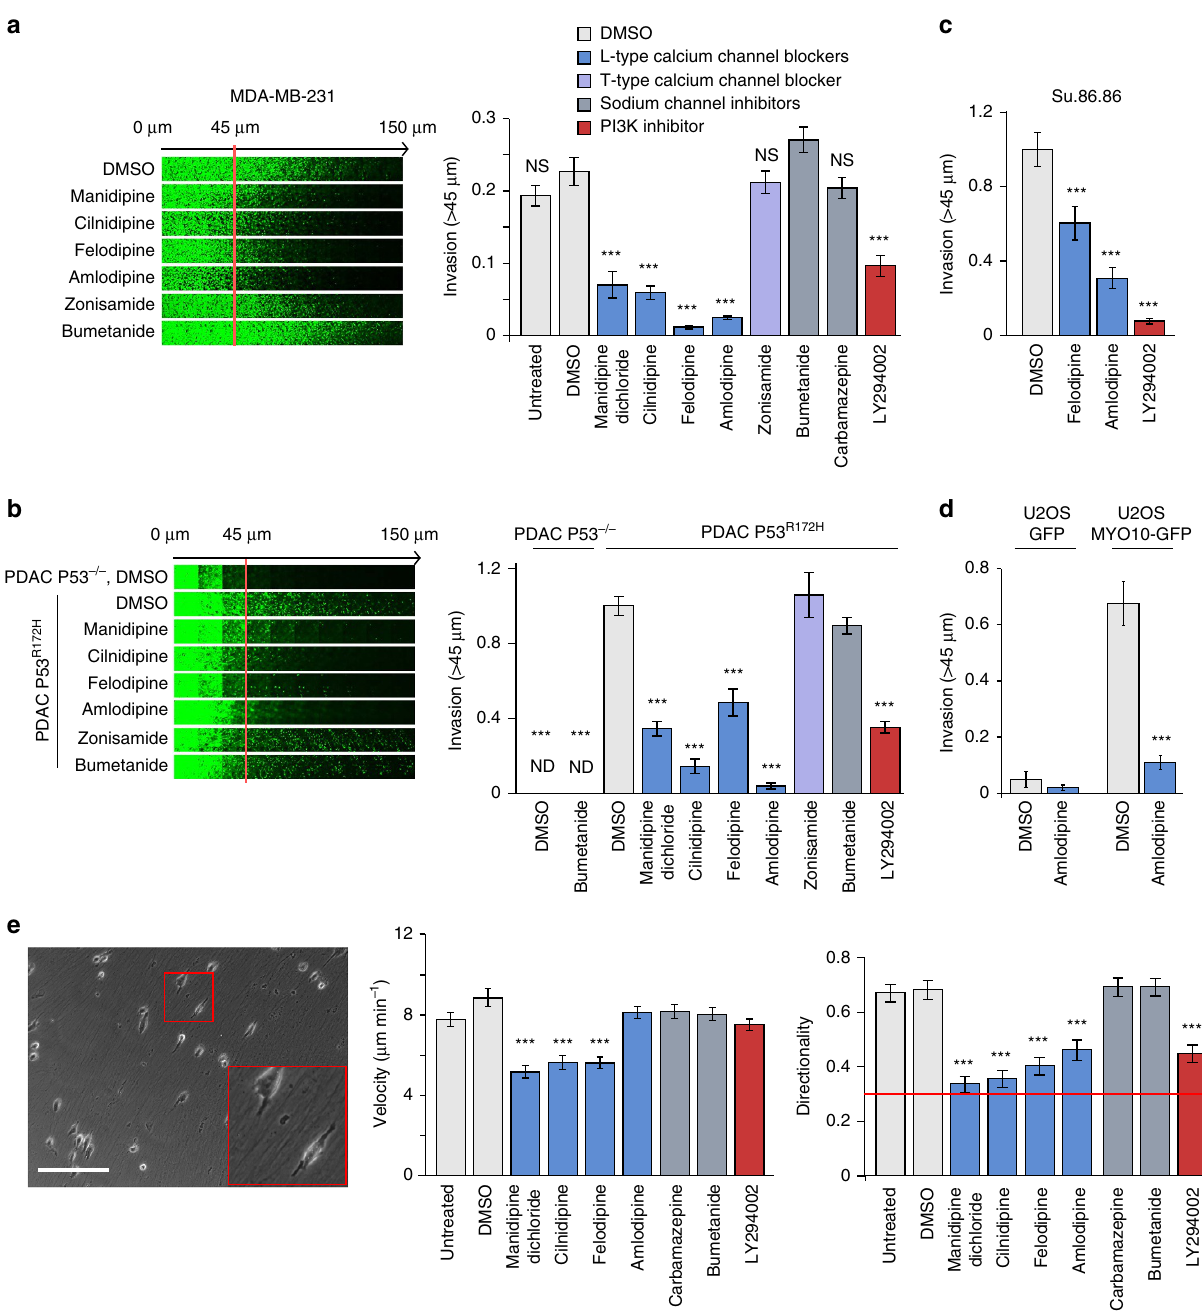
Figure 2 | L-type calcium channels regulate filopodia formation and cancer cell invasion. ( a ) MDA-MB-231 cells were seeded into an inverted invasion assay in the presence of various compounds (10 m M) where indicated for 48h. The relative invasion over 45 m m was quantified ( n ¼ three biological repeats, *** P value o 1.3 (cid:3) 10 (cid:2) 5 ). ( b ) P53 (cid:2) / (cid:2) and P53 R172H PDAC cells were seeded into an inverted invasion assay in the presence of various compounds (10 m M) for 4 days. The relative invasion over 45 m m was quantified ( n ¼ three biological repeats, *** P value o 4.1 (cid:3) 10 (cid:2) 8 ). ( c ) Su.86.86 pancreatic carcinoma cells were seeded into an inverted invasion assay and allowed to invade for 4 days in the presence of various compounds (10 m M). Relative invasion over 45 m m was quantified ( n ¼ three biological repeats, *** P value o 9 (cid:3) 10 (cid:2) 3 ). ( d ) U2OS cells stably expressing either GFP or MYO10-GFP were seeded into an inverted invasion assay and allowed to invade for 4 days in the presence of amlodipine besylate (10 m M) or DMSO. Relative invasion over 45 m m was quantified ( n ¼ three biological repeats, *** P value o 4.05 (cid:3) 10 (cid:2) 6 ). ( e ) MDA-MB-231 cells were seeded on fibroblast-generated cell derived matrices (representative image is shown) in the presence of various compounds (10 m M), and cell migration was recorded over 24h. Over 65 cells were manually tracked for each condition and migration speed and directionality were measured ( n ¼ two biological repeats, scale bar, 200 m m; *** P value o 2.6 (cid:3) 10 (cid:2) 5 ). P values were calculated using Student’s t -test (unpaired, two-tailed, unequal variance). All error bars represent dasatinib decreased filopodia number in the original microscopy- of Src (PP2) which triggered a significant loss in filopodia based drug screen (60% fewer filopodia than DMSO at 20 m M). compared with controls (PP3 and DMSO). In contrast, inhibition This result was validated using a small molecule inhibitor of FAK had no effect on filopodia formation (Fig. 6a;